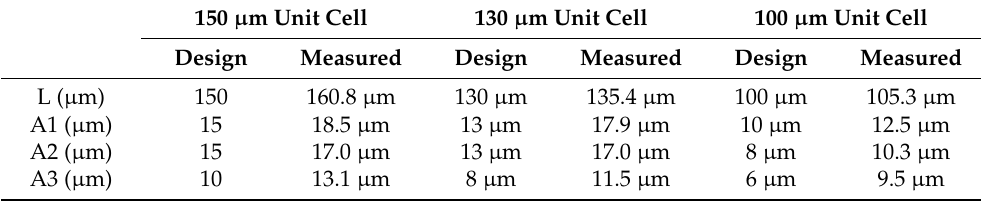
Figure 4. Schematic illustration on the effect of dark curing on the printed dimension of a square section. Past experience shows that if the UV blocker is not doing an adequate job under the chosen layer thickness and exposure time, the resulting structure may have an uppermost layer with well-defined truss elements such as those in Figure 3, while the interior, which suffers a higher number of repeated illuminations, may have its empty space partly or